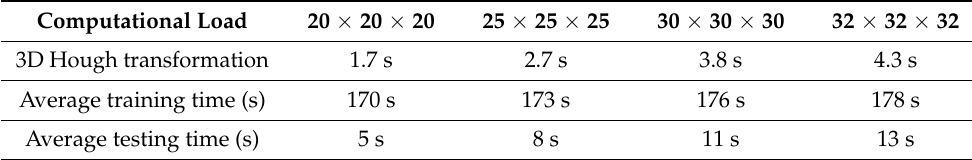
Table 3. Processing speeds for different Hough space resolutions.